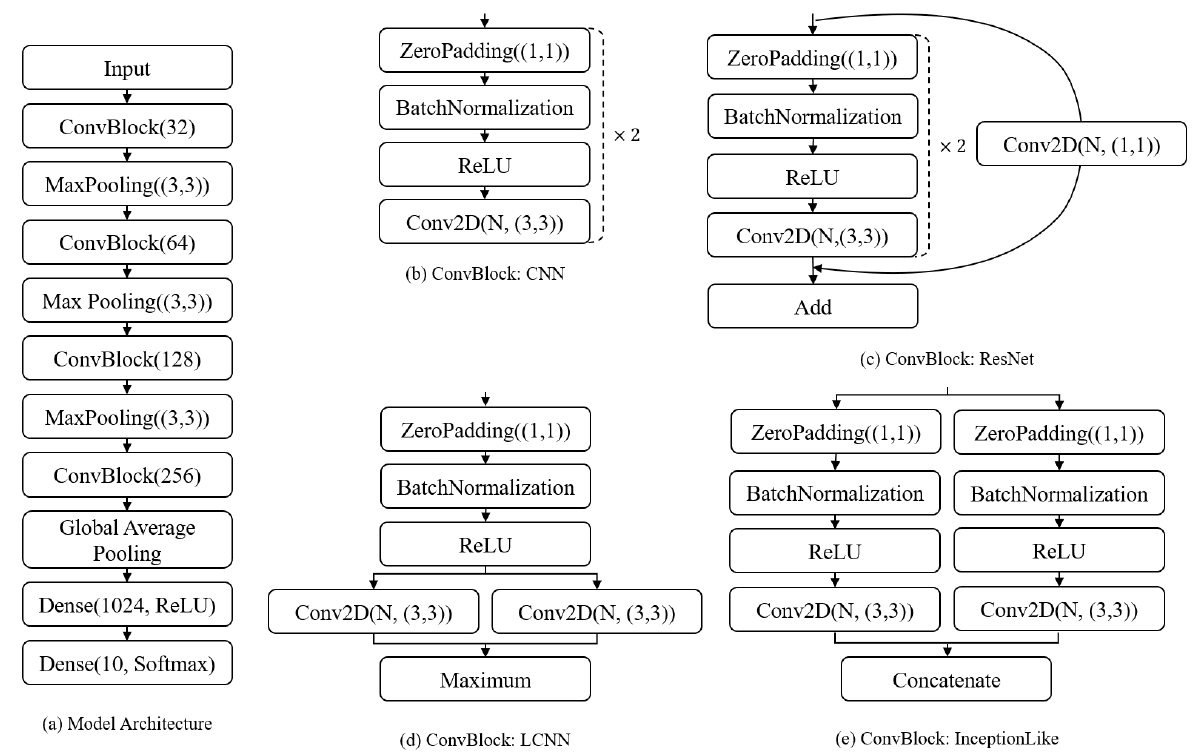
Figure 3. CNN architecture for subtask A. ( a ) General model architecture. ( b – e ): Four different modeling architectures for ConvBlock inspired by VGGNet , ResNet , LCNN , and InceptionNet,